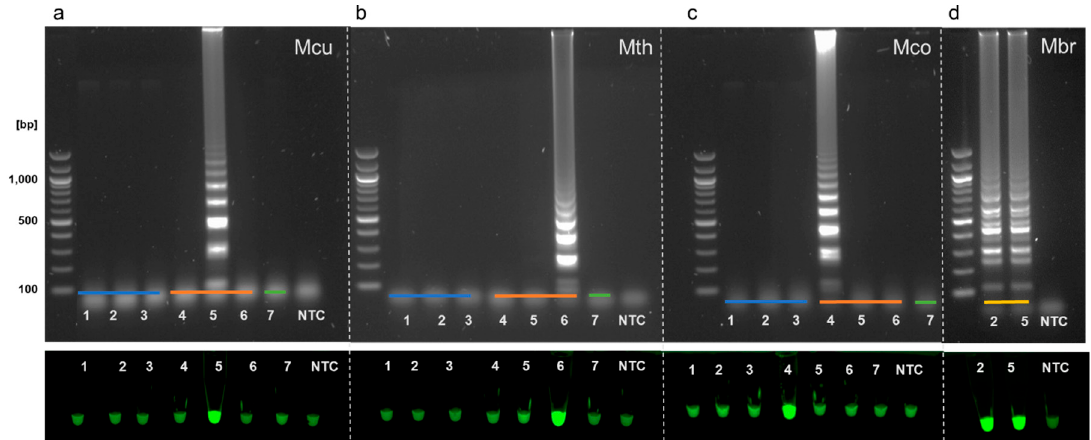
Figure 3. LAMP assay outputs comparing agarose gel electrophoresis (top of panels) and Sybr Green I end-point detection (bottom of panels). Specific F3 / B3 primers and genomic DNA from ( a ) Methanoculleus , ( b ) Methanothermobacter , ( c ) Methanococcus, and ( d ) Methanobrevibacter were used in assays performed with either Bst 3.0 ( a , c , d ) or Bst 2.0 ( b ). Bacterial DNA (blue line) originated from Escherichia coli (lane 1), Staphylococcus epidermidis (lane 2), and Bacillus sp. 3PL (lane 3). Archaeal DNA (orange line) originated from Methanococcus maripaludis (lane 4), Methanoculleus marisnigri (lane 5), and Methanothermobacter thermoautotrophicus (lane 6), eukaryotic DNA was extracted from wheat root rhizobiome (green line, lane 7). For ( d ), eDNA extracted from two Methanobrevibacter positive (see Figure 2) stool samples was used as a template (yellow line). A non-template control (NTC) was included in all assays.